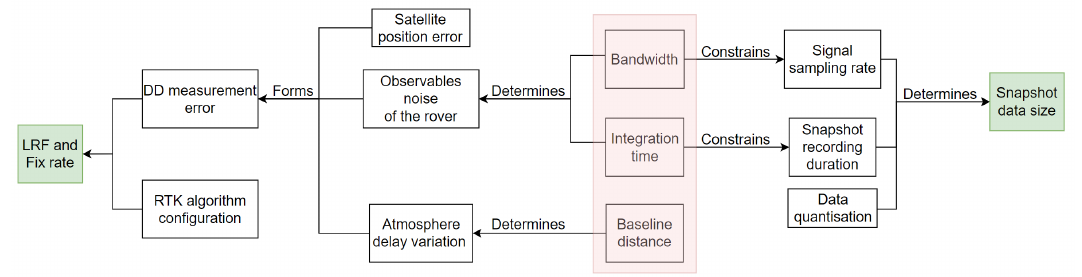
Figure 5. Relationships between the parameters of